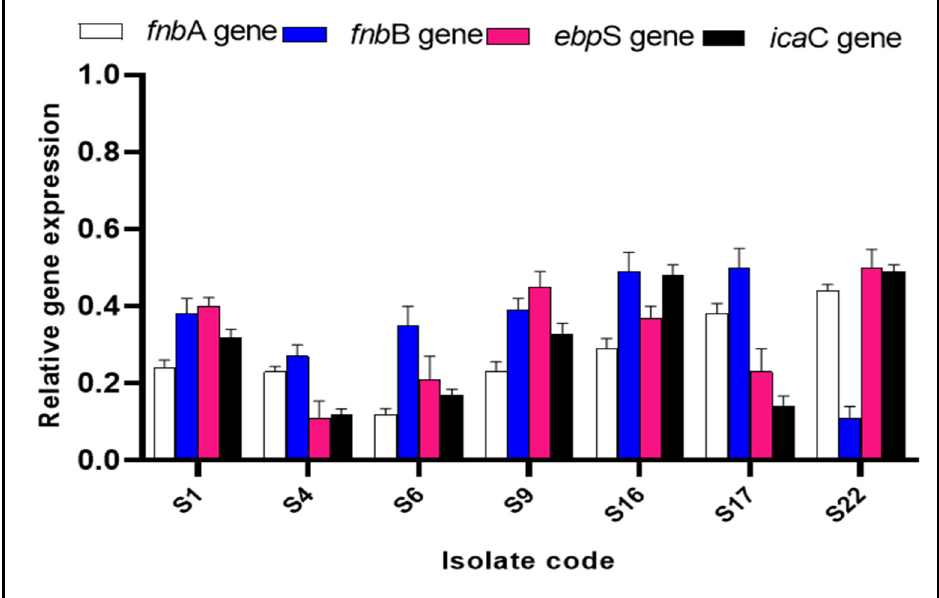
Figure 5. Bar chart showing the downregulation of the biofilm genes in the seven S. aureus isolates (S1, S4, S6, S9, S16, S17, S22) after treatment with ZnO NPs.